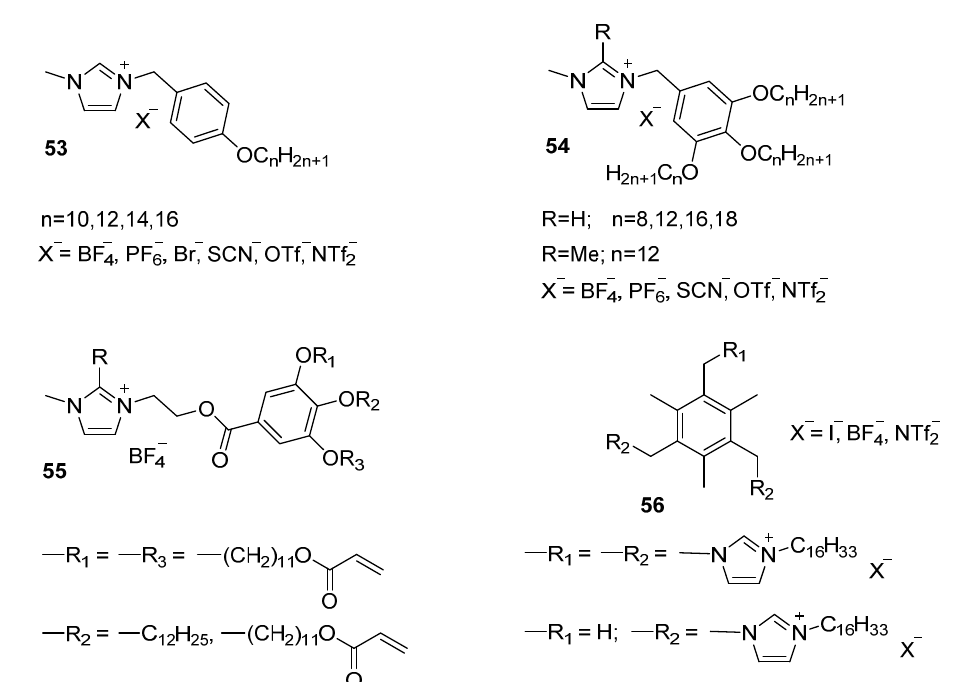
Figure 12. Imidazolium-based ILCs conjugated to aromatic groups bridged by a short aliphatic spacer. The number of tails, as well as the number of cationic cores is readily modified in this